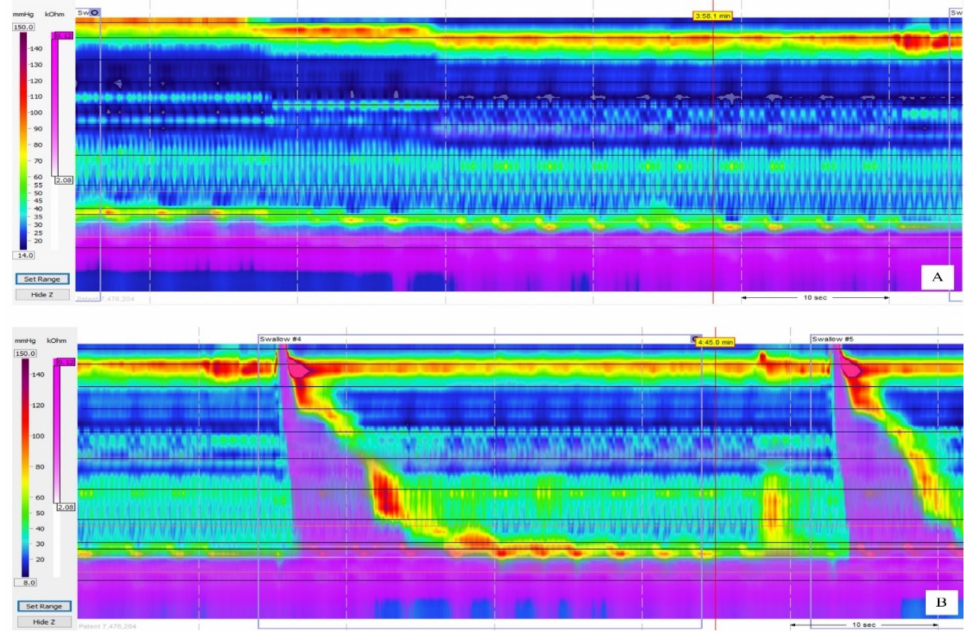
Figure 2. Illustration of esophageal pressure pattern during stationary ( A ) and swallowing ( B ) stages in grade D